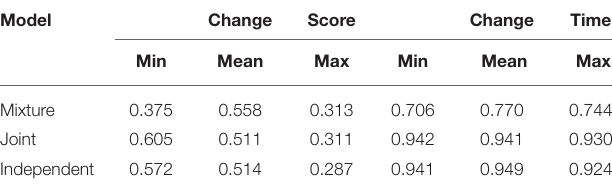
TABLE 2 | Posterior predictive p -values for three testing quantities. Model